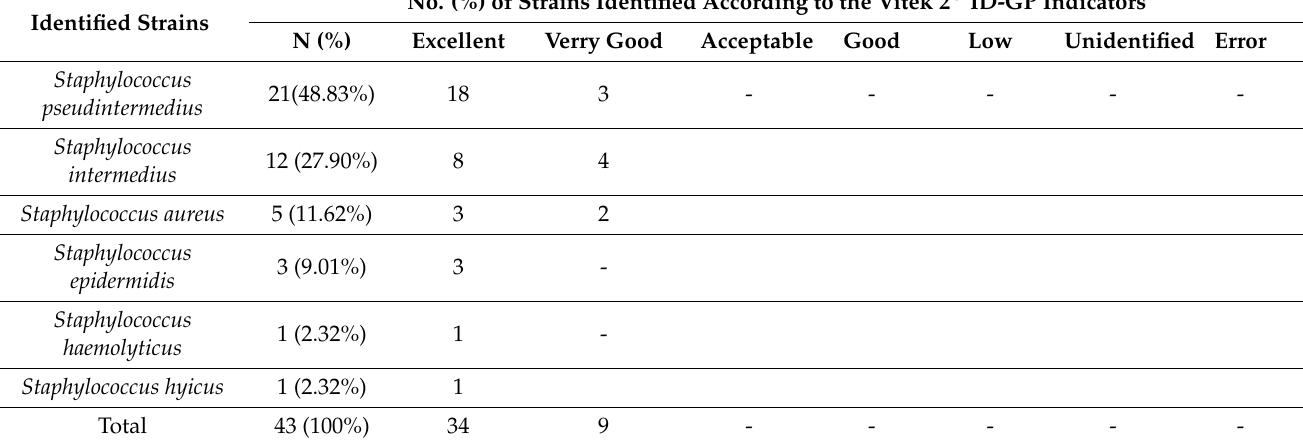
Table 2. Result of Staphylococcus spp. strains testing with Vitek 2 ® ID-GP identification card (bioM é rieux. Marcy l’Etoile, France).